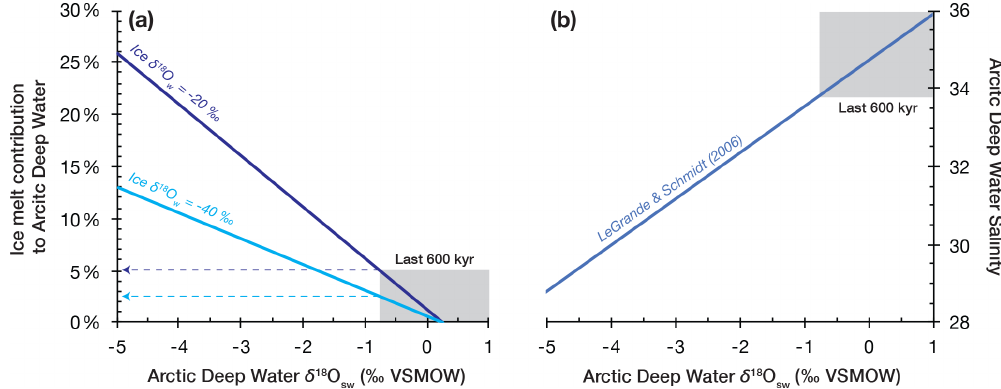
Figure 6. Two-component mixing models for the δ 18 O sw of Arctic Deep Water (a) by mixing with hypothetical ice melt of − 20‰ (blue) and − 40‰ (cyan) and (b) based on the modern δ 18 O sw –salinity relationship of the deep Arctic Ocean (LeGrande and Schmidt, 2006). Gray boxes denote the observed range of local Arctic δ 18 O sw (from (cid:49)δ 18 O sw ) in our records (Fig. 4d). Dashed arrows in (a) indicate the maximum ice melt contribution needed to explain the lowest Arctic δ 18 O sw in our